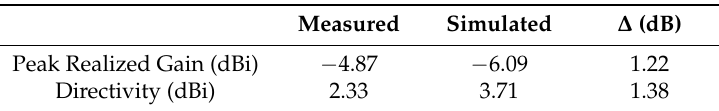
Table 8. Comparison between measured and simulated radiation characteristics of the antenna on the IXB-063 phantom column.